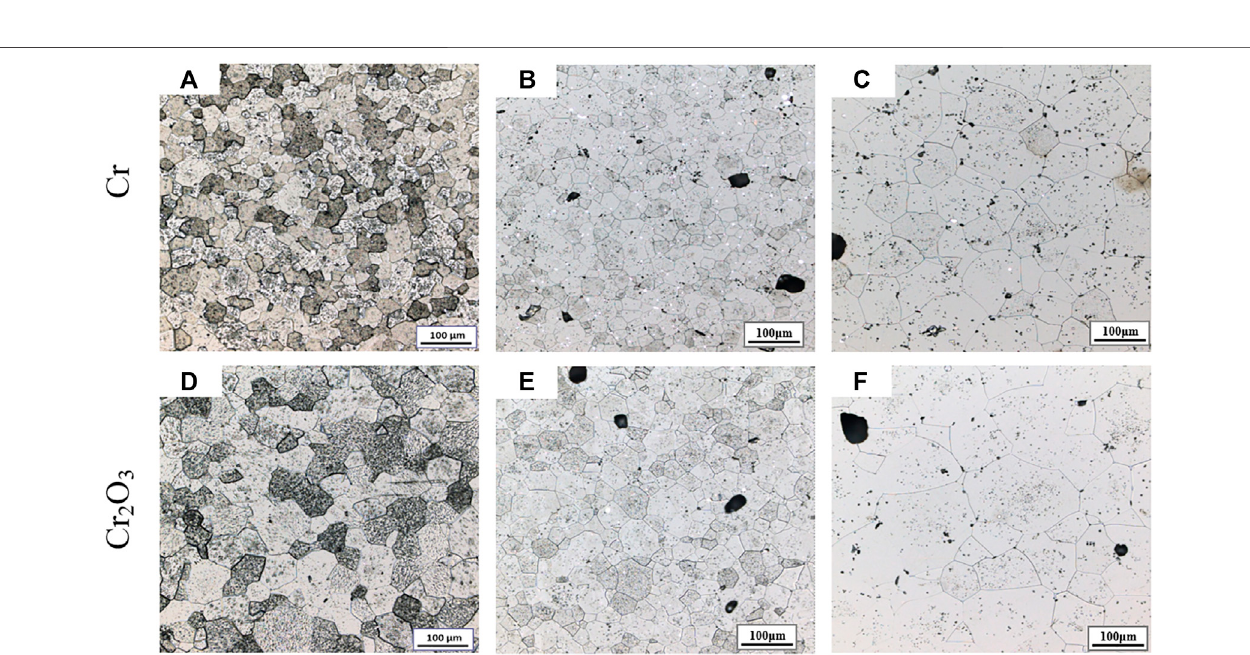
FIGURE 7 | Grain morphologies of Cr and Cr 2 O 3 doped UO 2 sintered under different sintering atmospheres. (A) H 2 ; (B) H 2 -H 2 O; (C) H 2 -CO 2 ; (D) H 2 ; (E) H 2 -H 2 O; (F) H 2 -CO 2